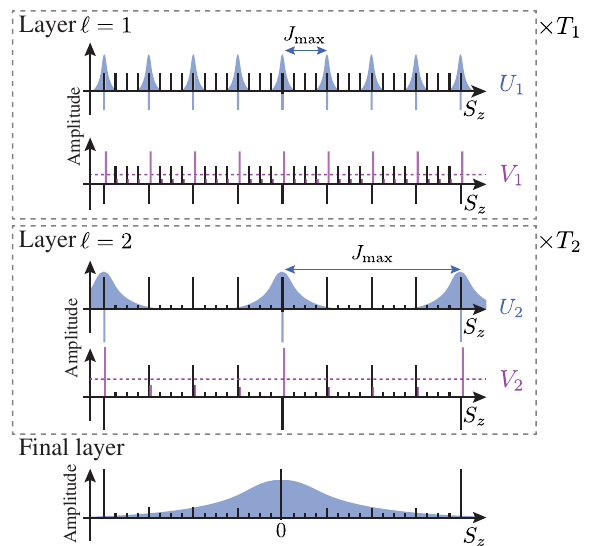
FIG. 6. Sketch of the scalable algorithm, showing amplitudes of basis states versus S z . Each layer (cid:16) of the algorithm consists of T (cid:16) amplification cycles, each comprising the modular oracle U (cid:16) and recursive inversion operator V (cid:16) . The modular oracle acts on states spaced in energy by J max with a spectral resolution γ J max illustrated by the shaded blue curves. The operator V (cid:16) inverts the amplitudes of the states amplified by the previous layer of the algorithm about their average (dashed purple line). Implementing V (cid:16) requires recursion to the lower layers of the algorithm. In the final layer (cid:16) = k / m , the standard nonmodular oracle is used.